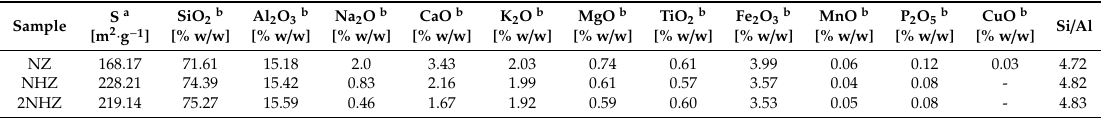
Table 2. Physico-chemical characterization of natural and modified Chilean zeolite samples.